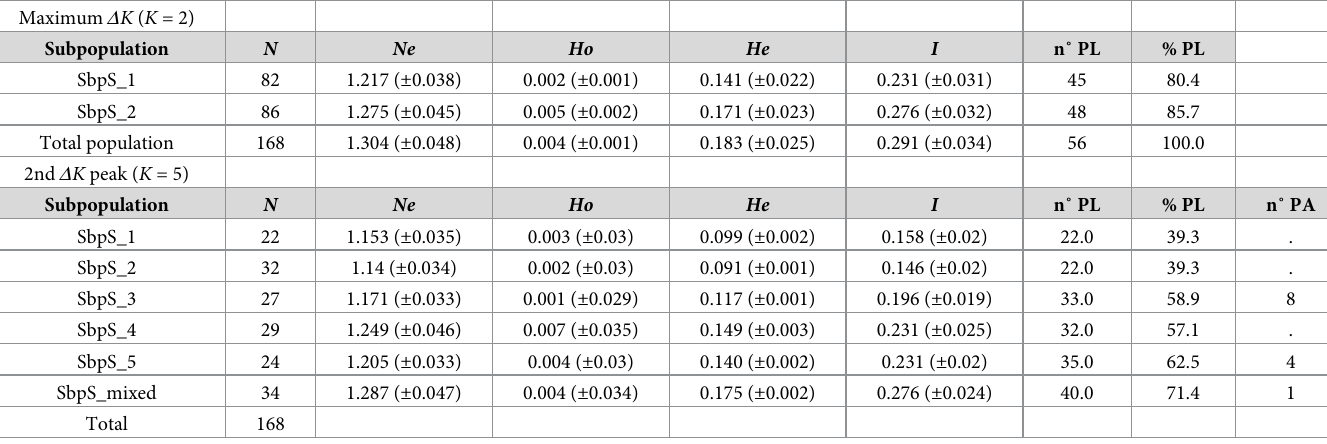
Table 7. Genetic diversity among subpopulations assessed using 56 SNP markers in a durum wheat collection of 168 accessions. Maximum Δ K ( K =